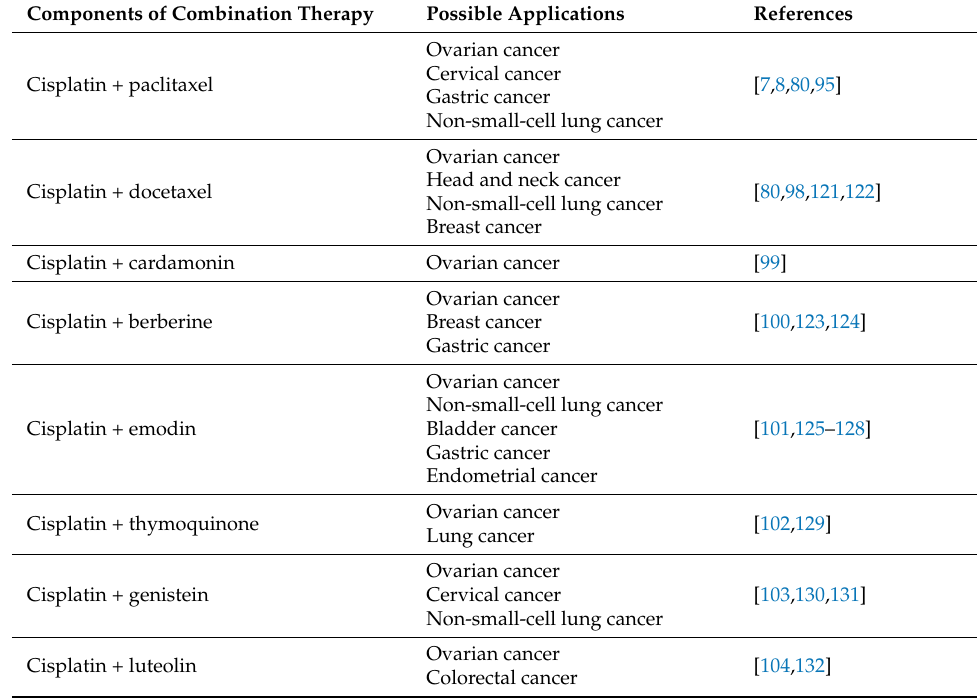
Table 1. Examples of combination therapies with cisplatin. Components of Combination Therapy Possible